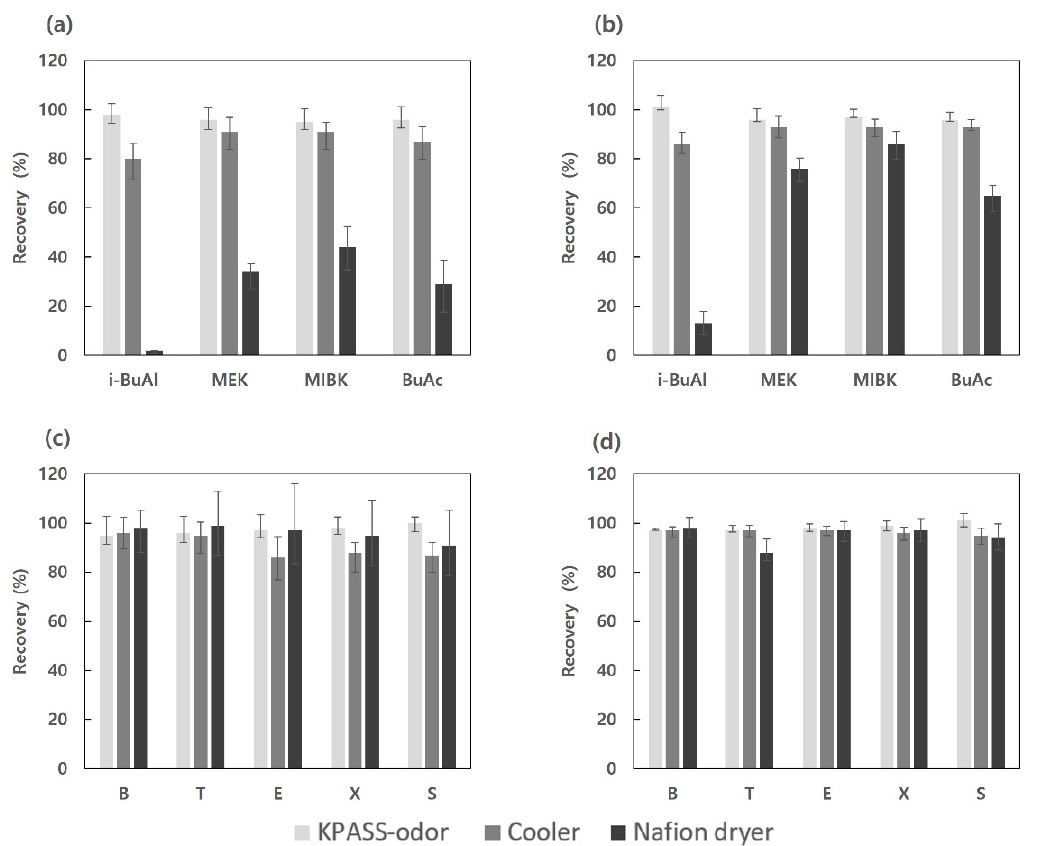
Figure 7. Variations in recovery rates by moisture pretreatment devices with respect to flow rates: ( a ) 200 mL/min, high solubility; ( b ) 500 mL/min, high solubility; ( c ) 200 mL/min, low solubility; ( d ) 500 mL/min, low solubility.